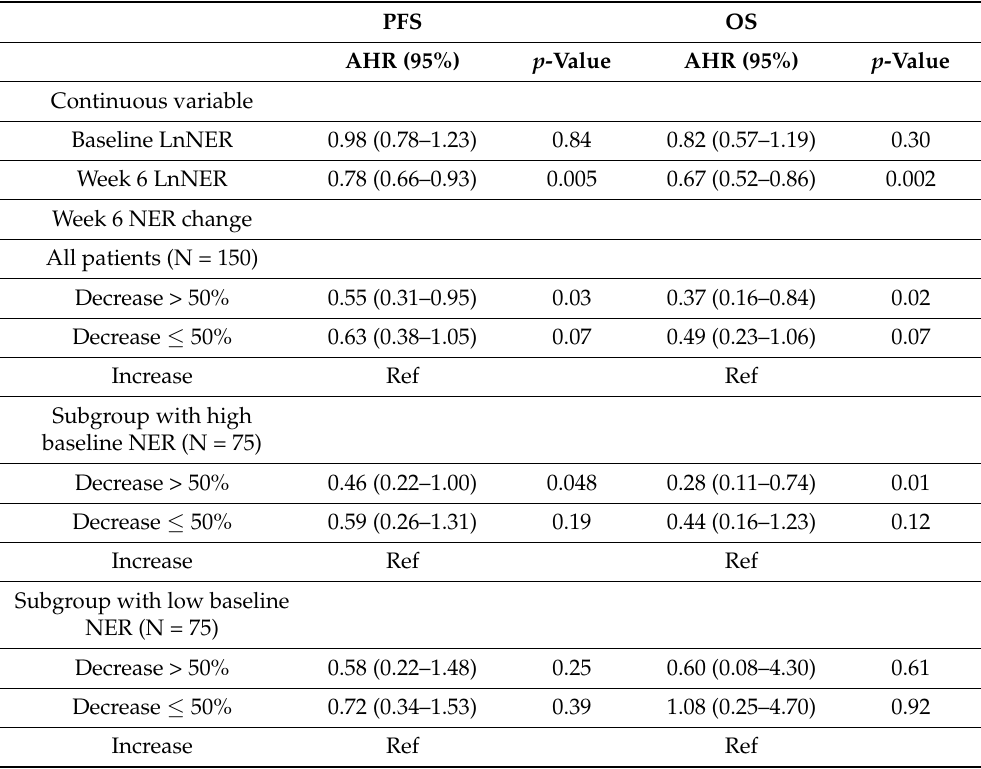
Table 2. Multivariable regression analysis of NER and clinical